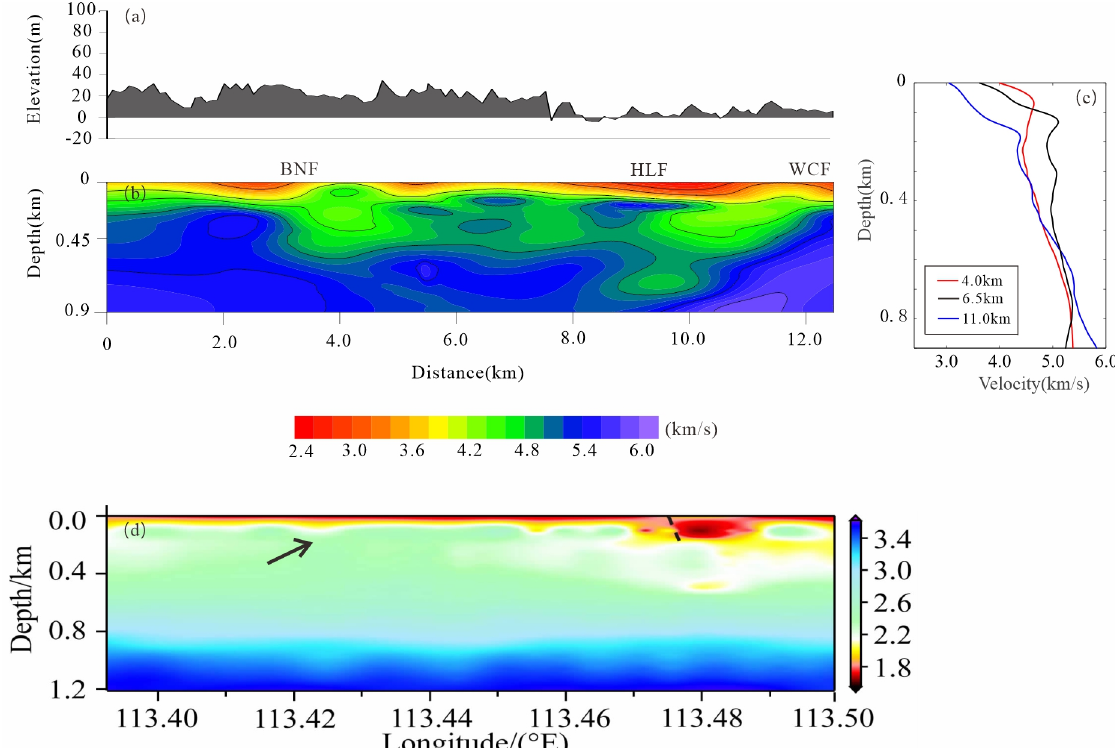
Figure 10. Schematic illustrating ( a ) the surface elevation of this survey line, ( b ) final waveform inversion results, ( c ) the depth − velocity profiles at positions of 4 km (red), 6.5 km (black), and 11 km (blue) of the inversion velocity model, and ( d ) the shear wave velocity profile obtained from ambient noise double beamforming (Wu et al., 2022).